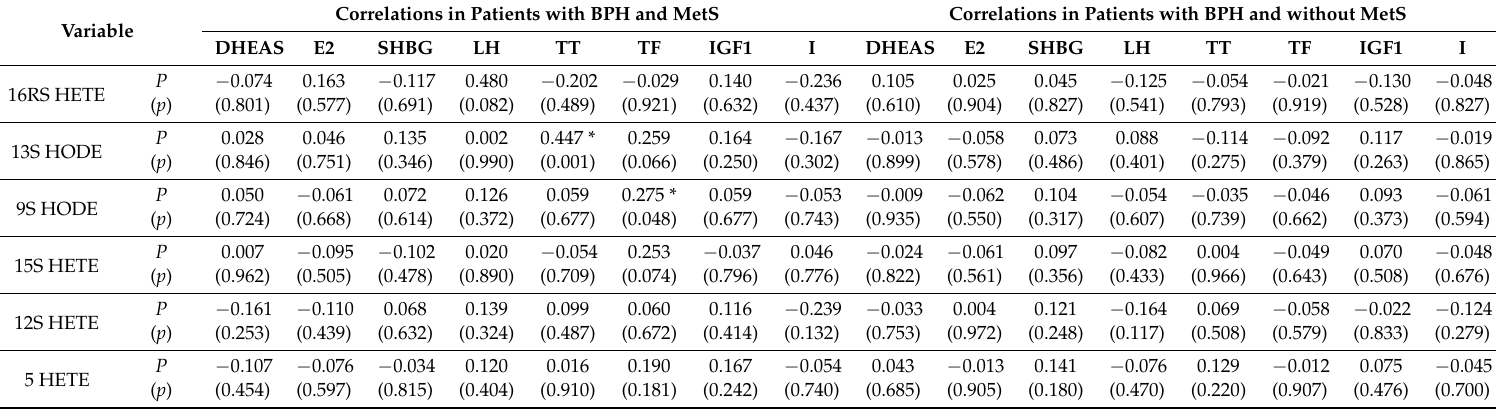
Table 4. Correlations between hormonal parameters and the levels of the selected polyunsaturated fatty acids in BPH patients with and without MetS. Correlations in Patients with BPH and MetS Correlations in Patients with BPH and without Variable